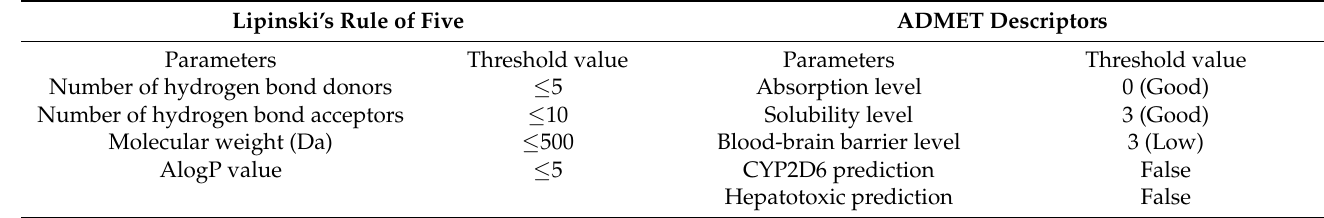
Table 3. Details of parameters used for the generation of the drug-like database. Lipinski’s Rule of